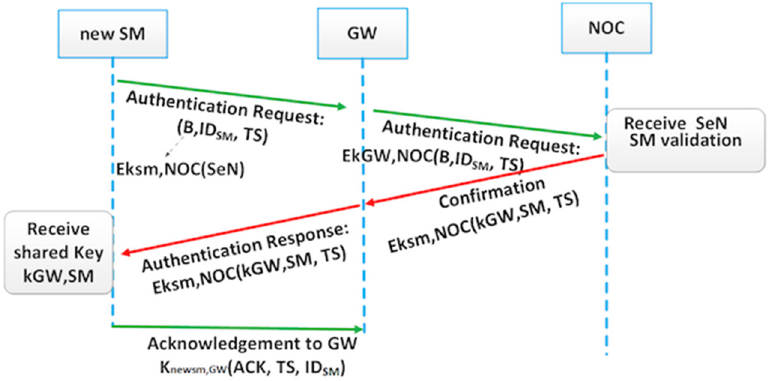
Figure 5. Authentication for NAN in a star topology.